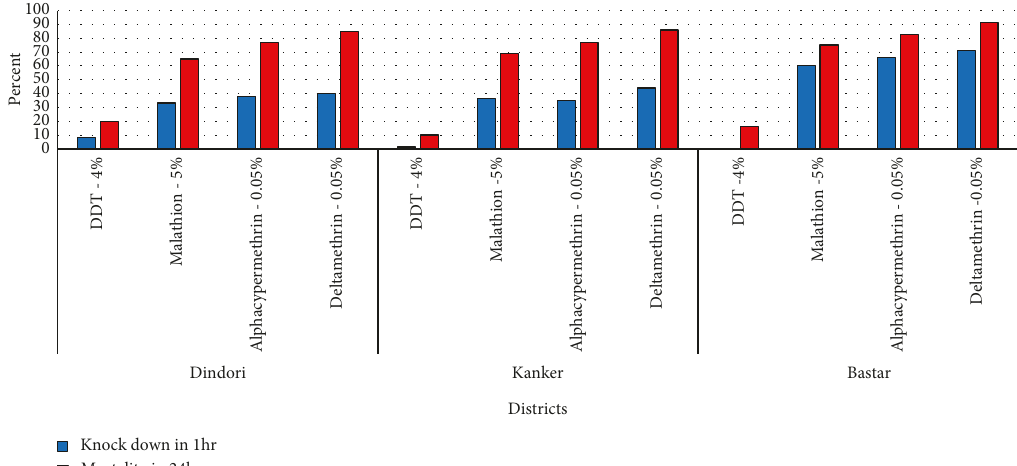
Figure 2: Phenotype insecticide susceptibility status of An. culicifacies s.l. to discriminatory dosages of different insecticides in district Dindori (Madhya Pradesh state) and districts Kanker and Bastar in Chhattisgarh states during 2021-2022. Table 1: Intensity bioassay test of Anopheles culicifacies against pyrethroid insecticides in district Dindori (Madhya Pradesh state) and districts Kanker and Bastar in Chhattisgarh state in the Year 2022 No. exposed Test/ Insecticide/ Control Districts (State) (Replicates) Control